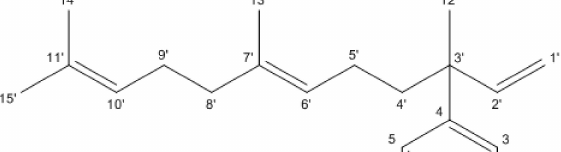
Figure 1. 4-Nerolidylcatechol infrared spectrum.